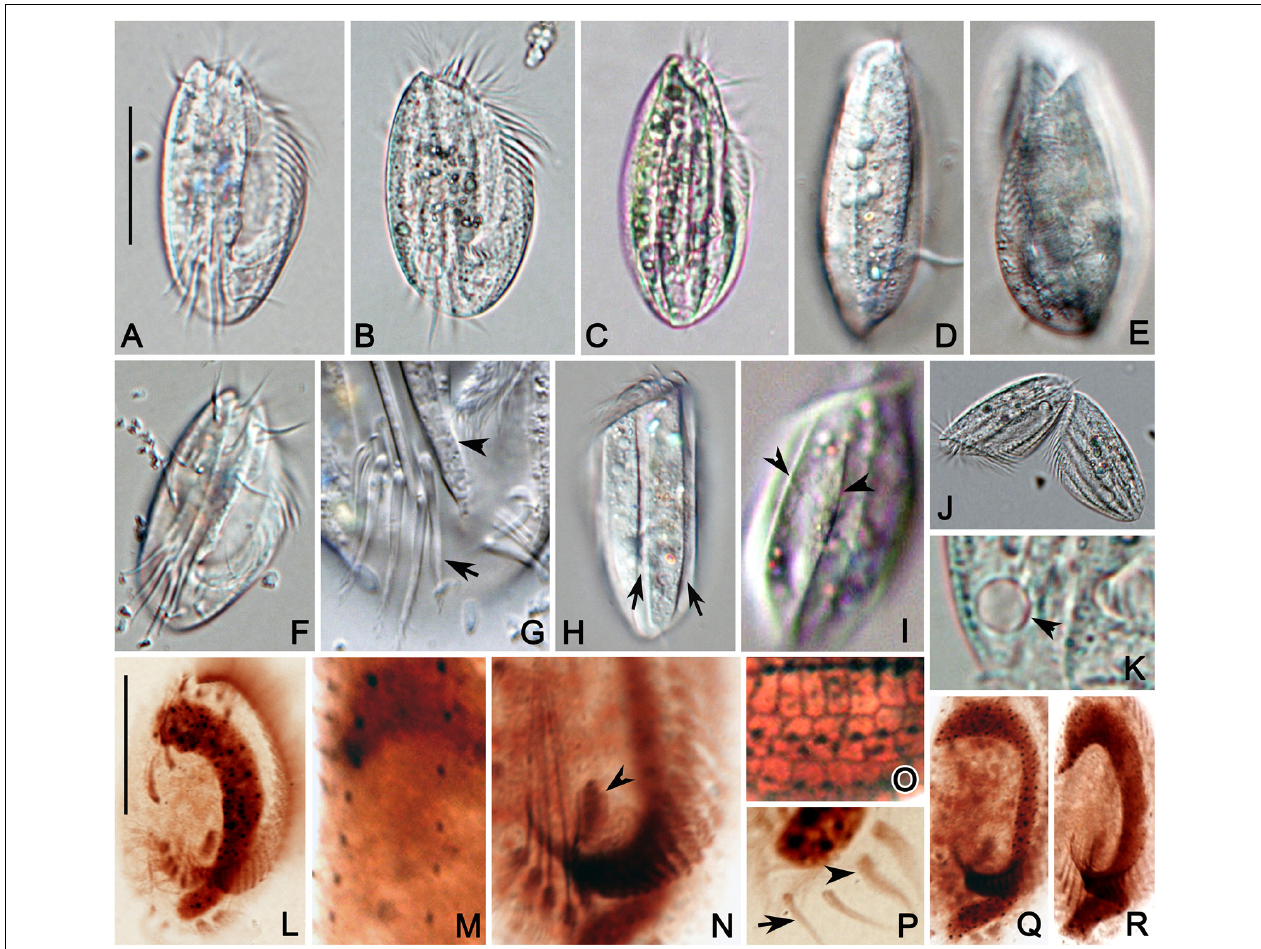
FIGURE 4 | Photomicrographs of E. antarcticus in vivo (A–K) , and after protargol (L–N,P–R) and silver nitrate (O) impregnation. (A) A representative specimen. (B,C) Cells of different shapes. (D,E) Right (D) and left (E) views showing the slightly convex dorsal side. (F) Ventral view showing the cirri. (G) Detail of posterior portion of ventral side to show the transverse cirri (arrow) and ridges (arrowhead). (H,I) Dorsal views to show the grooves (arrow) formed by inclined ridges (arrowhead). (J) A late divider. (K) Detail of contractile vacuole (arrowhead). (L) Ventral view of infraciliature. (M) Detail of dorsal kineties. (N) Center portion of ventral side to show the transverse cirri, paroral membrane (arrowhead) and posterior end of AZM. (O) Detail of dorsal view of silverline system. (P) Posterior portion of ventral side showing the marginal (arrowhead) and caudal (arrow) cirri. (Q,R) Macronucleus of different shapes. Scale bars = 30 µ m.